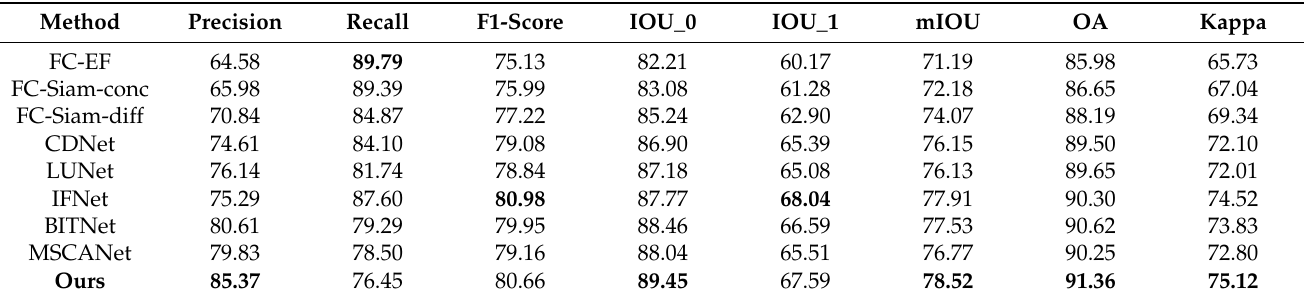
Table 4. Quantitative comparisons of various CD methods from the SYSU-CD dataset.